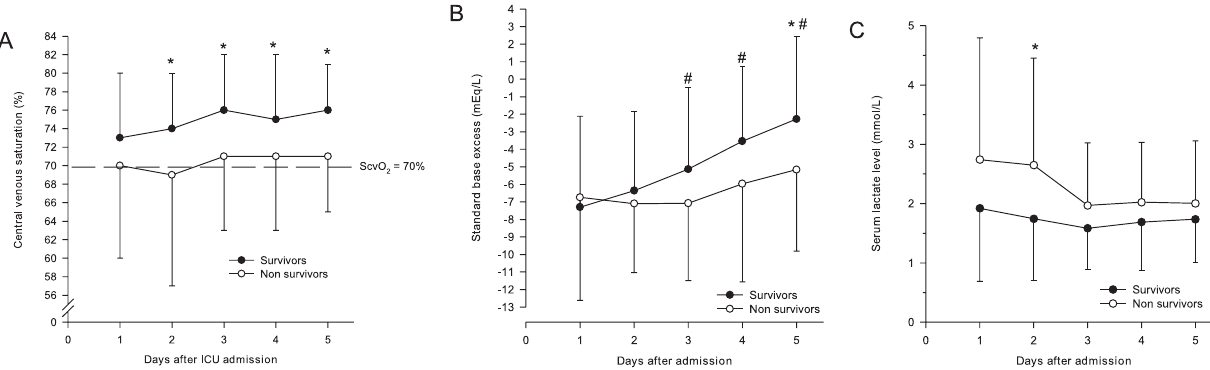
Figure 1 - Panel A. Central venous saturation of survivors and non survivors, the analysis within group did not disclose differences during the evolution (P = 0.358, ANOVA two way). (*) Between groups there were differences in days 2,3,4 and 5 (P < 0.001, ANOVA two way with Tukey post hoc analysis). There was not factor time interaction (P = 0.964, ANOVA two way). Panel B. Standard base excess of survivors and non survivors, the analysis within group (#) disclose differences during the evolution (P < 0.001, ANOVA two way, with Tukey post hoc analysis showing differences between the days 3,4 and 5